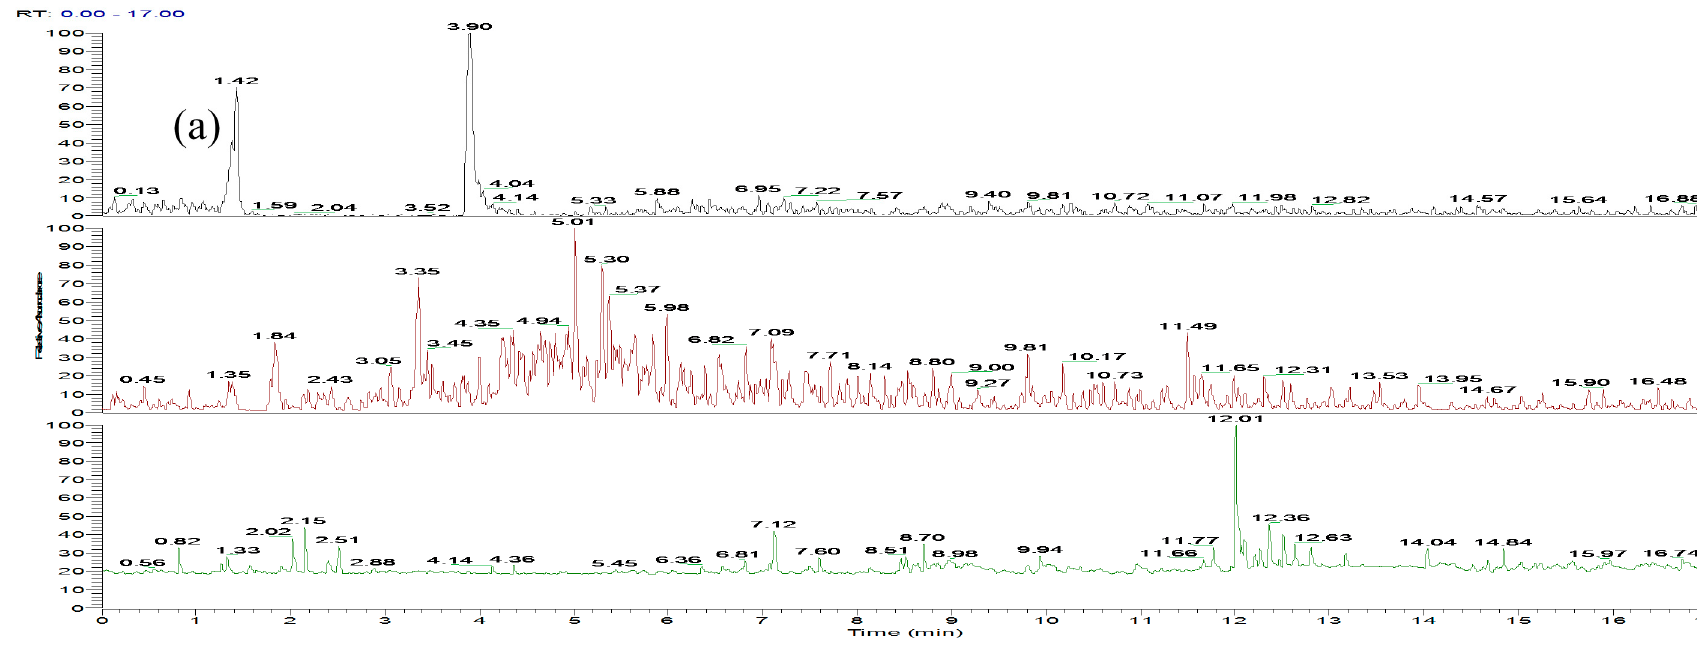
Figure 1. Cont Figure 1. Cont .